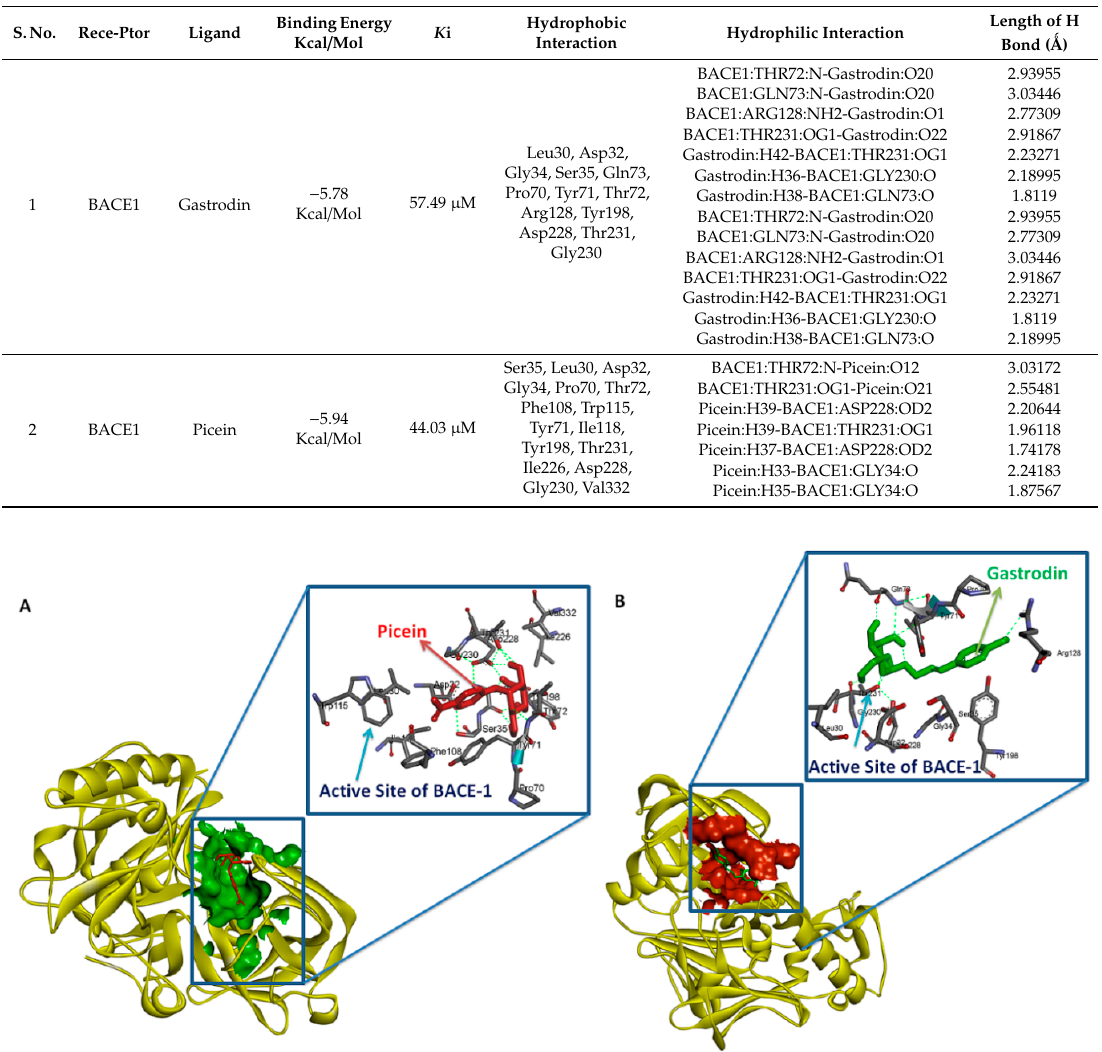
Table 2. Binding interaction analysis of gastrodin and picein with BACE1.